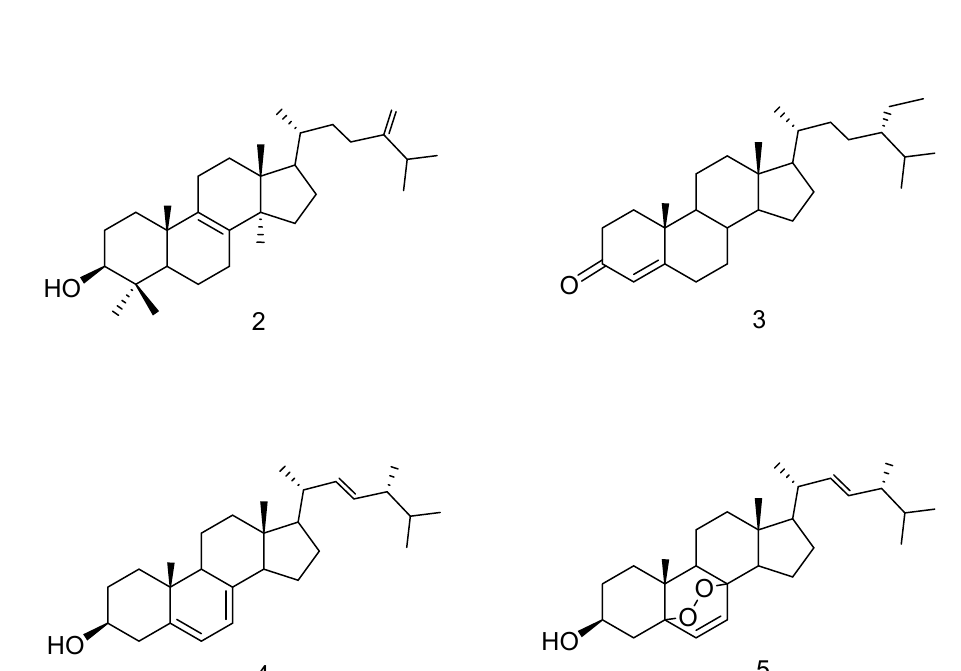
Figure 1. Molecular structures of compounds 2 (4,4,14 α ,24-tetramethyl-5 α -cholesta-8, 24(24 ′ )-dien-3 β -ol (eburicol), 3 stigmast-4-ene-3-one ( β -sitostenone), 4 (ergosta-5, 7, 22-triene-3 β -ol, ergosterol) and 5 ((3 β ,5 α ,8 α ,22E)-5,8-epidioxyergosta-6,22-dien-3-ol, ergosterol peroxide). Table 4. Antifeedant effects of mixture 1, the free fatty acids from the hydrolysis of mixture 1 (1A), their methylated esters (1M) and compounds 2 – 5 on Myzus persicae .